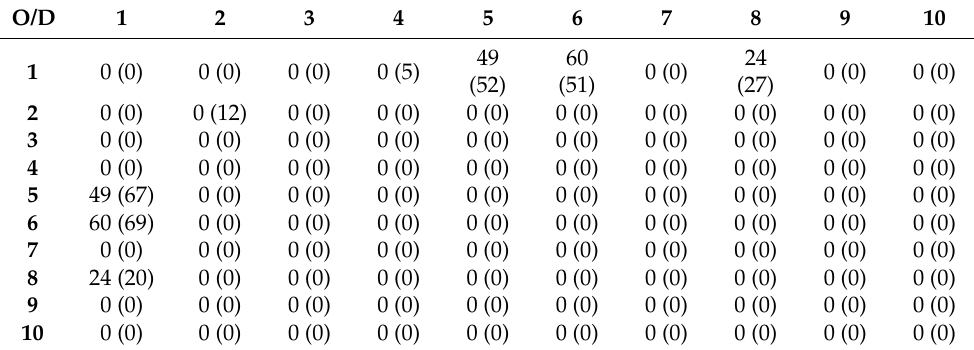
Table 1. Estimated average travel times for the first ten origin/destination (OD) pairs in the network. (Values in parentheses show the current research